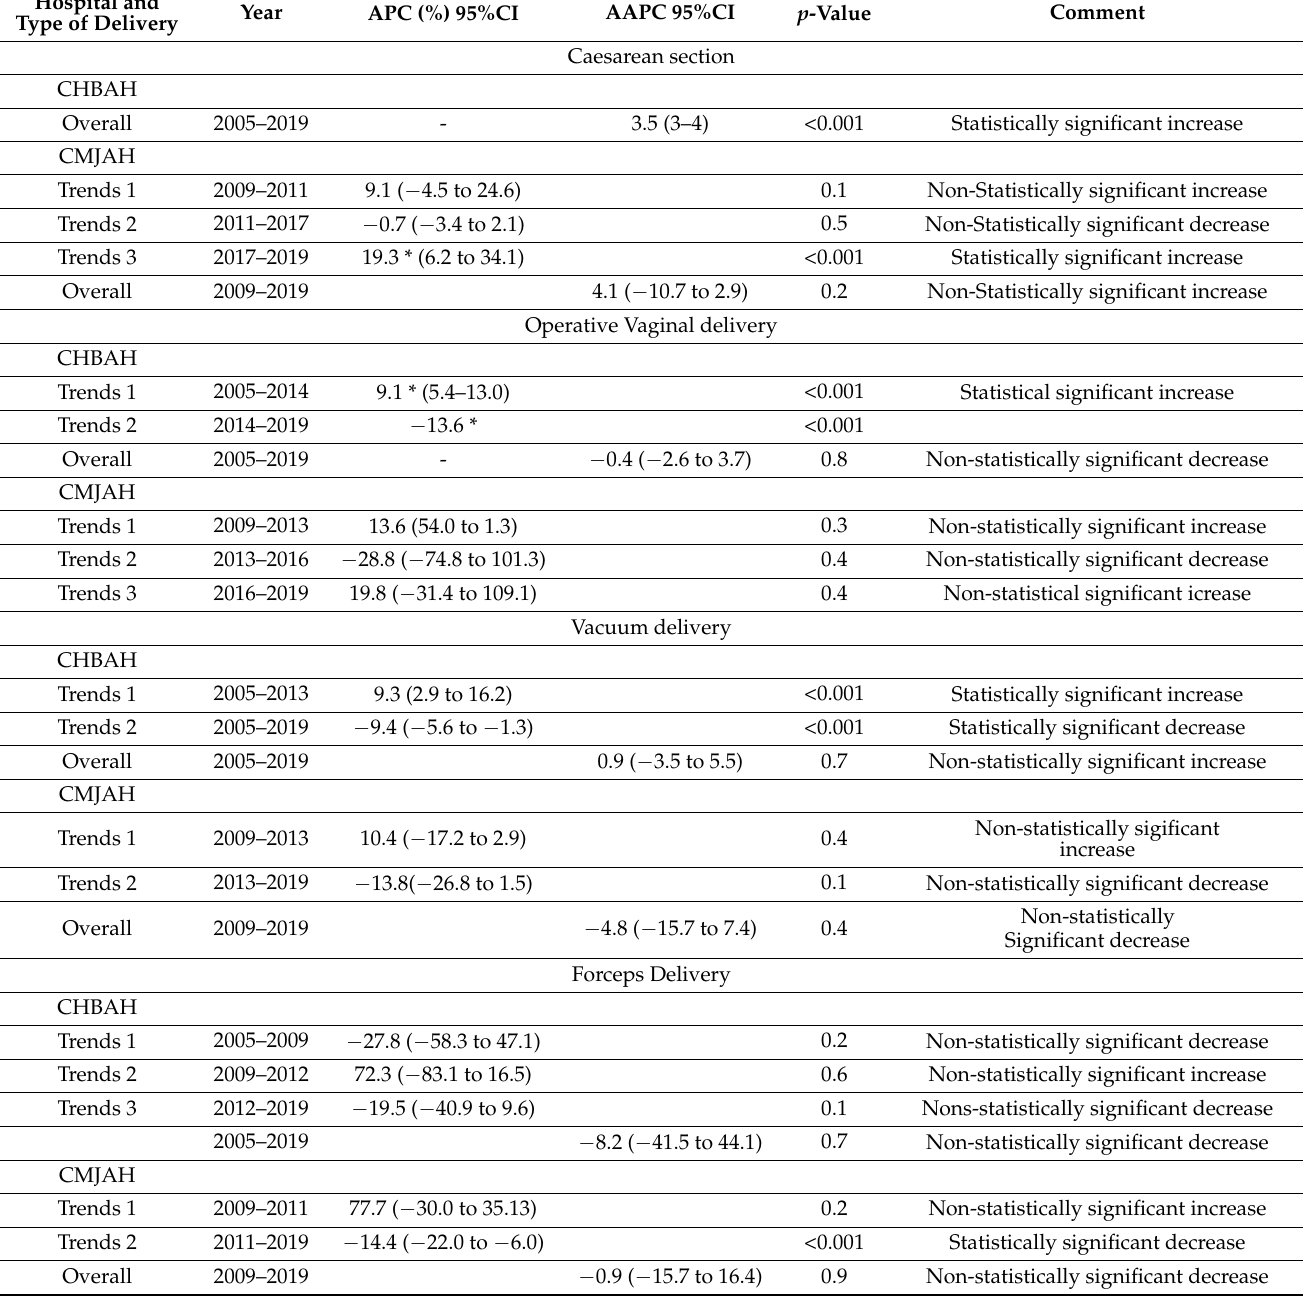
Table 1. Join point regression of the trends in the caesarean section and operative vaginal deliveries at two academic hospitals in Johannesburg